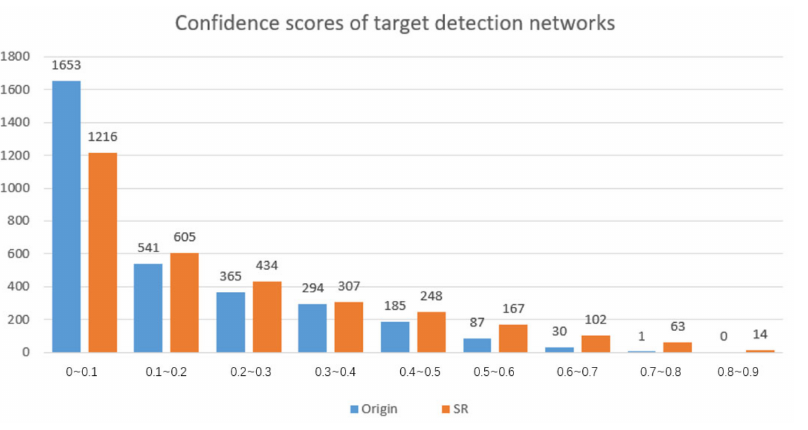
Figure 9. The confidence score statistical histogram of Origin and SR images in target recognition network detection.